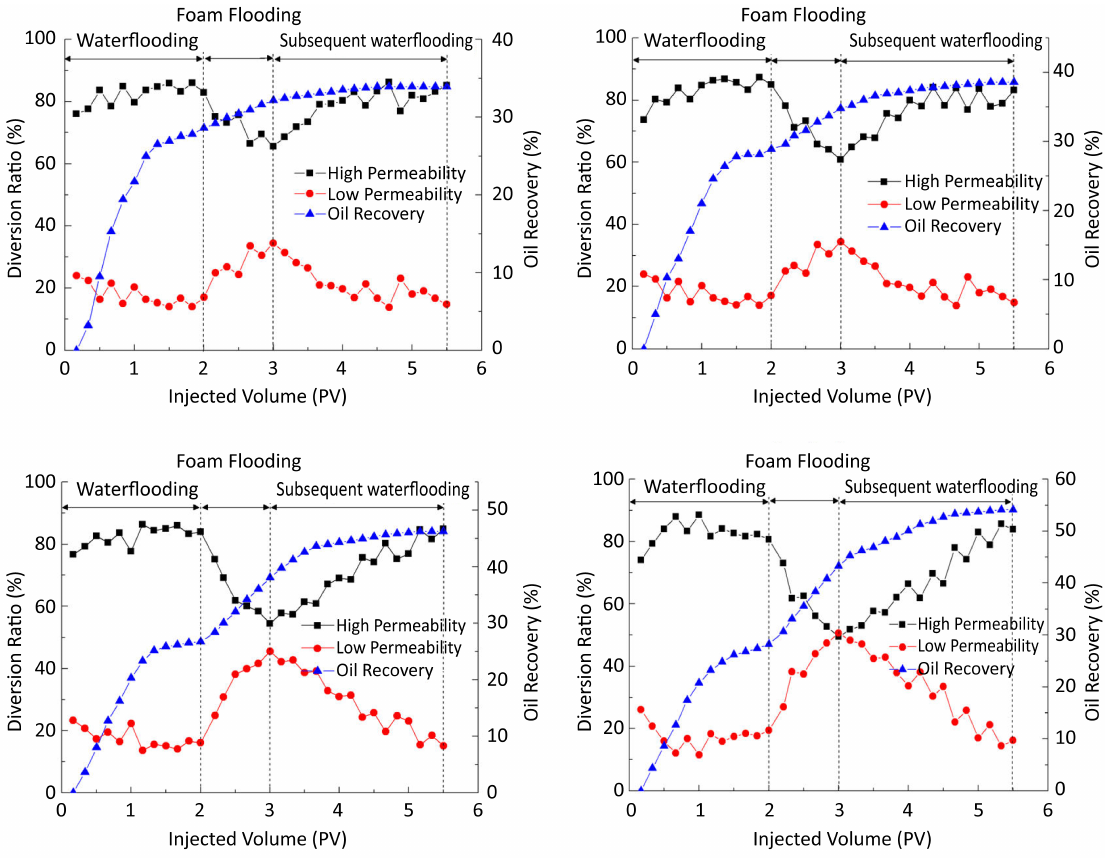
Figure 24. Oil recovery during EOR flooding: ( top left ) 0.5 wt % SDS, ( top right ) 0.1 wt % SiO 2 + 0.5 wt % SDS, ( bottom left ) 1.5 wt % SiO 2 + 0.5 wt % SDS, and ( bottom right ) 2.0 wt % SiO 2 + 0.5 wt % SDS. Figure reproduced from Ref.